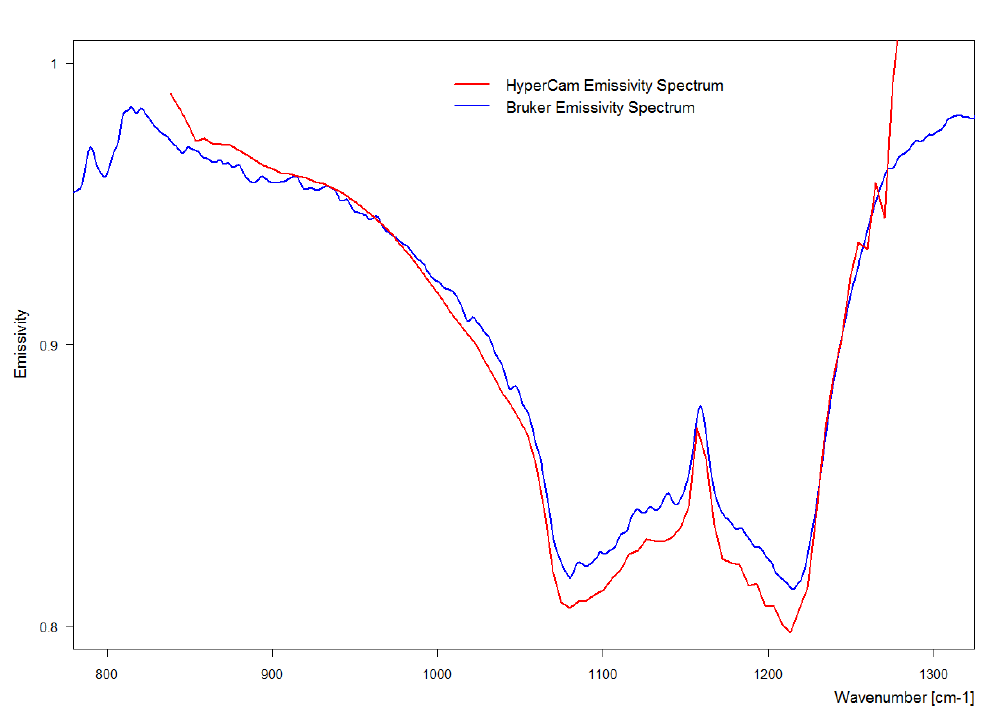
Figure 5. Emissivity spectra of the Bunter Sandstone sample derived from the Hyper-Cam (red) and from the Bruker